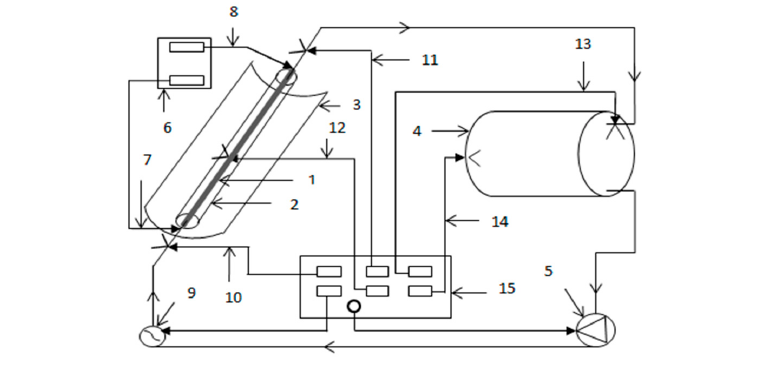
Figure 1. The schematic diagram of the CPCSWH (cylindrical parabolic concentrating solar water heater) experimental setup.